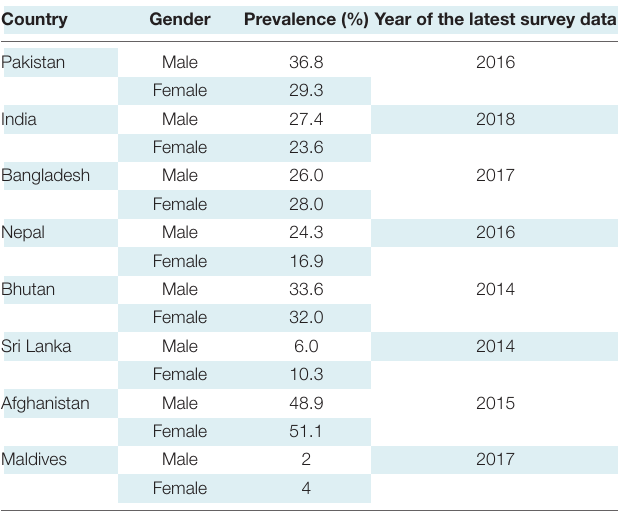
TABLE 1 | Prevalence of hypertension in South Asian countries according to most recent available data.